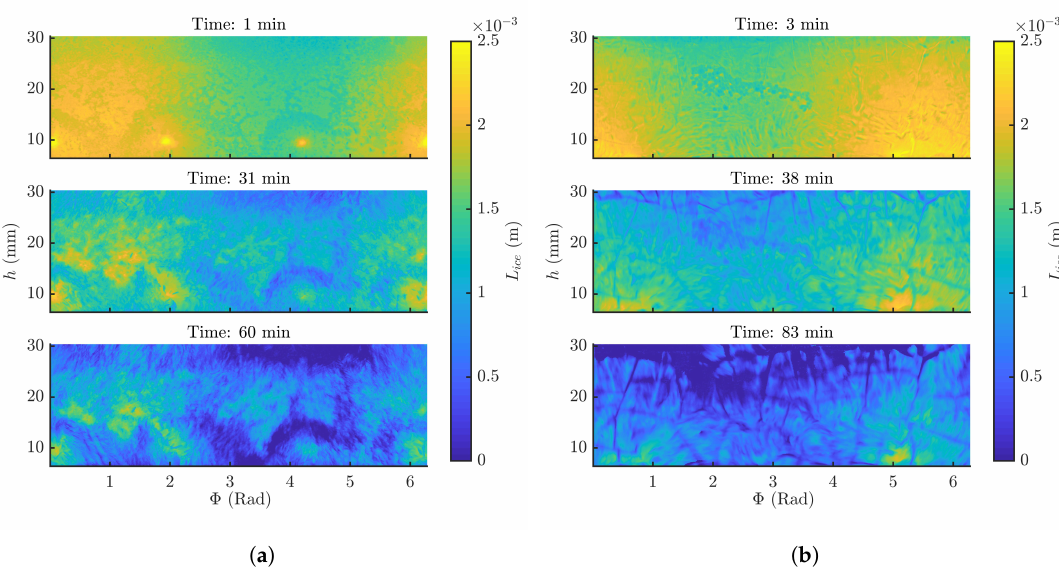
Figure 5. ( a ) Frozen product layer thickness L ice , i for every ( Φ , h ) coordinate in function of time of a 3% mannitol formulation during spin freeze-drying ( b ) Frozen product layer thickness L ice , i for every ( Φ , h ) coordinate in function of time of a 4% BSA formulation during spin